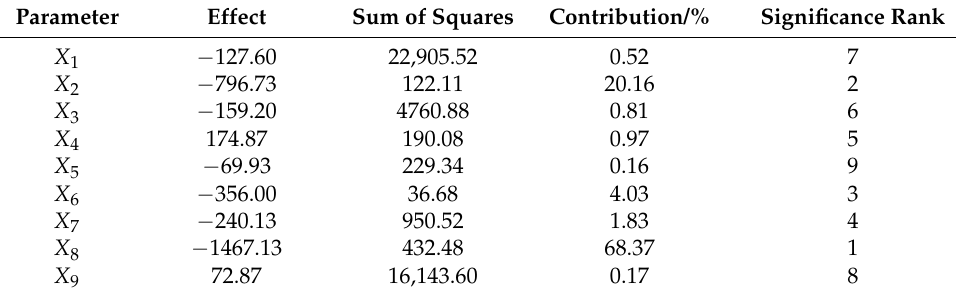
Table 4. Significance analysis of parameters in PB